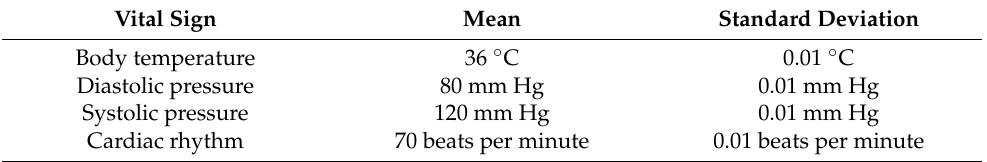
Table A6. Reference for the mean and standard deviation of vital signs in normal conditions.